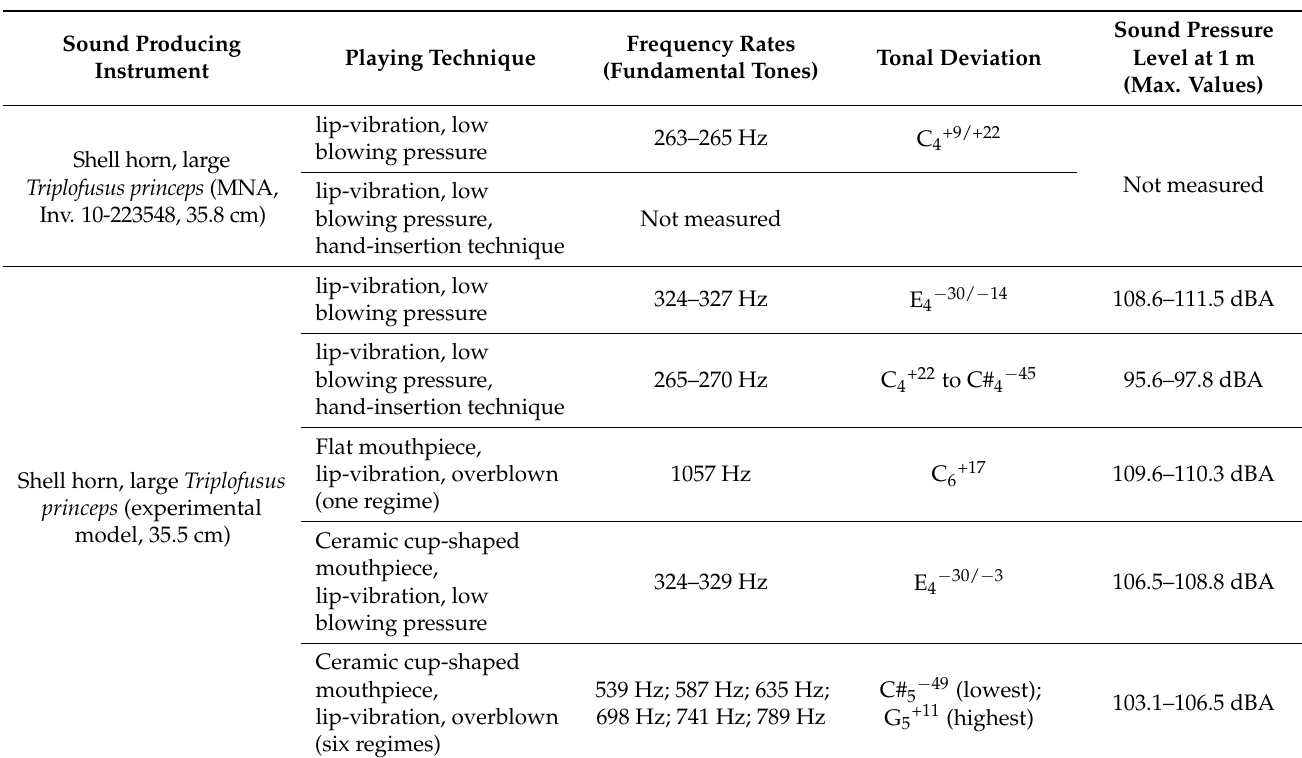
Figure 4. Spectral components of the stuccoed shell horn made from Triplofusus princeps , Teotihuacan (MNA, Inv. 10-223548), low blowing pressure: ( a ) spectrogram; ( b ) spectrum (Sample S1). Table 1. Acoustic data sheet of the analyzed shell